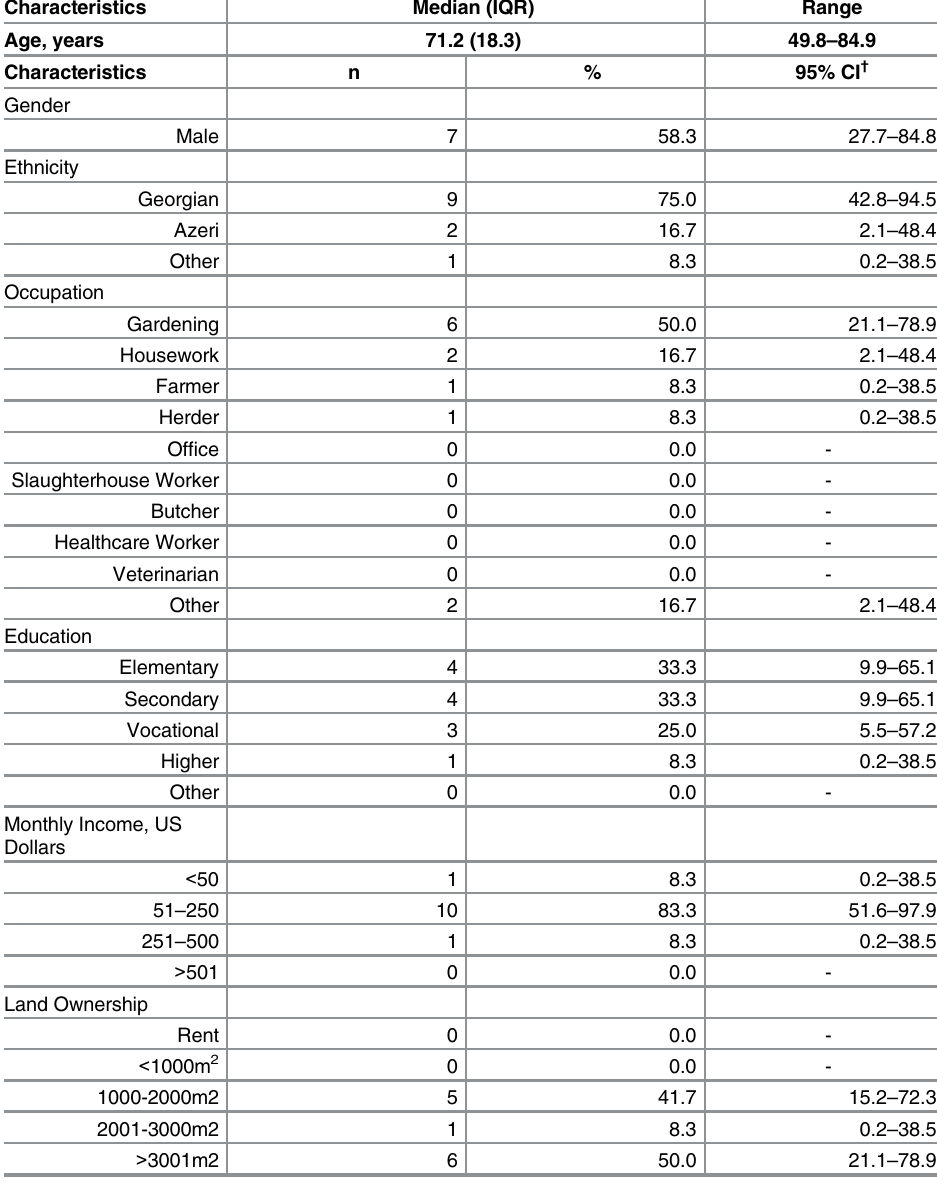
Table 6. Crimean-Congo hemorrhagic fever (CCHF) seropositive subjects ’ demographics among sur- vey participants during an investigation of the 12 rural villages reporting at least one 2014 CCHF case from January to September 2014 in Georgia (N =